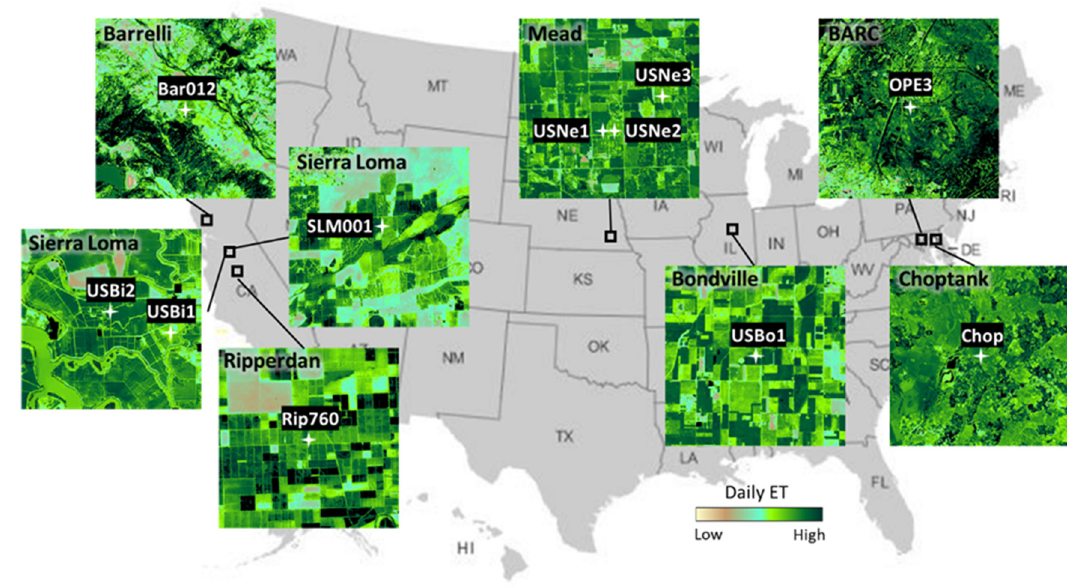
Figure 2. Study area covering the U.S. The ET maps show subregions (300 × 300 30 m pixels) of the seven study area domains, with flux tower sites indicated with white crosses.